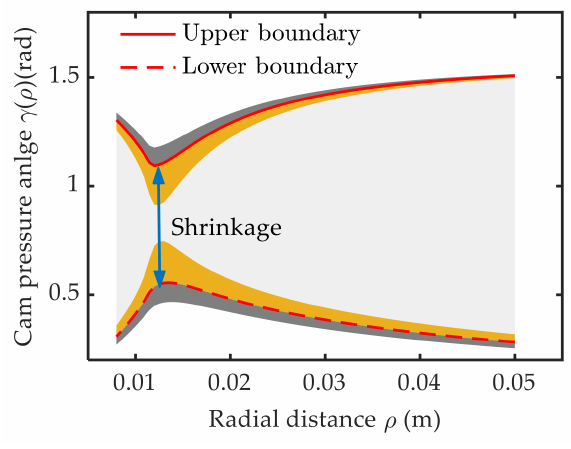
Figure 5. Solution space constrained by bearing’s rated